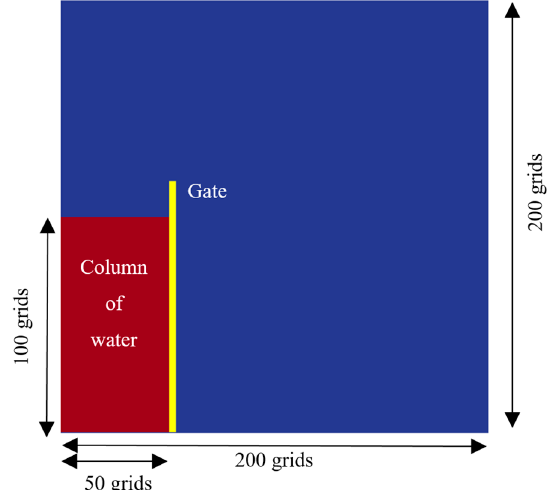
Figure 1. Schematic view of initial condition including problem geometry.